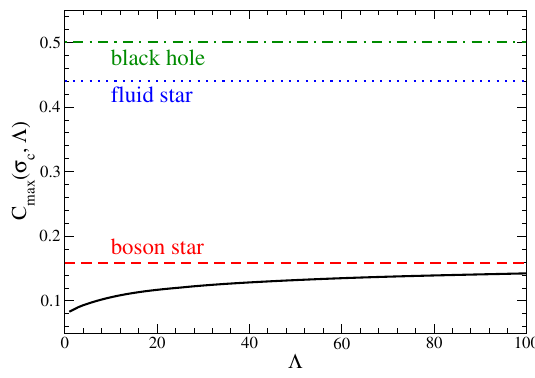
Fig. 4 The compactness of a stable boson star (black solid line) as a function of the adimensional self- interaction parameter K (cid:2) k = 4 p Gm 2 ð Þ . The compactness is shown for the most massive stable star (the most compact BS is unstable). This compactness asymptotes for K ! 1 to the value indicated by the red, dashed line. Also shown for comparison is the compactness of a Schwarzschild BH (green dot-dashed line), and the maximum compactness of a non-spinning neutron star (blue dotted line). Reproduced with permission from Amaro-Seoane et al. (2010), copyright by